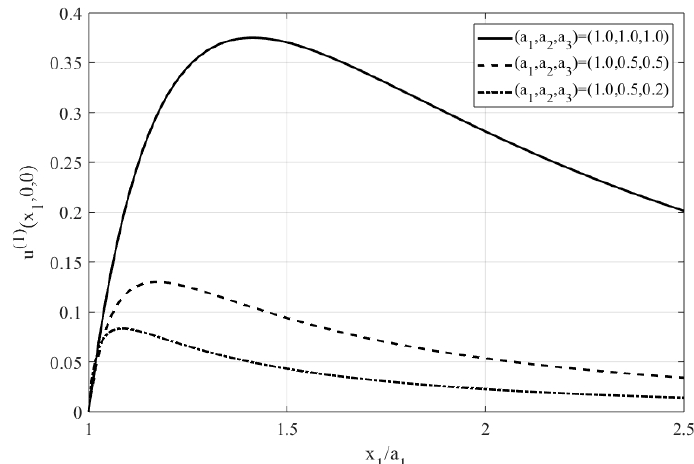
Figure 2. A plot of the normalized velocity component (the term in the square bracket of Equation (48)) versus x 1 / a 1 for various morphologies (i.e., sphere, spheroid and tri-axial ellipsoid).